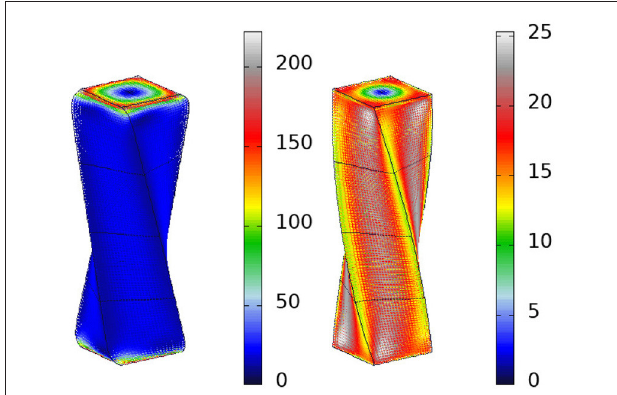
FIGURE A3 | A square prism beam structure, sides L = 25, and height H = 101, loaded in tension ( Z ), pure bending ( V ), and the two combined ( ZV ). are included in Table A1 . Here, F 090 and P